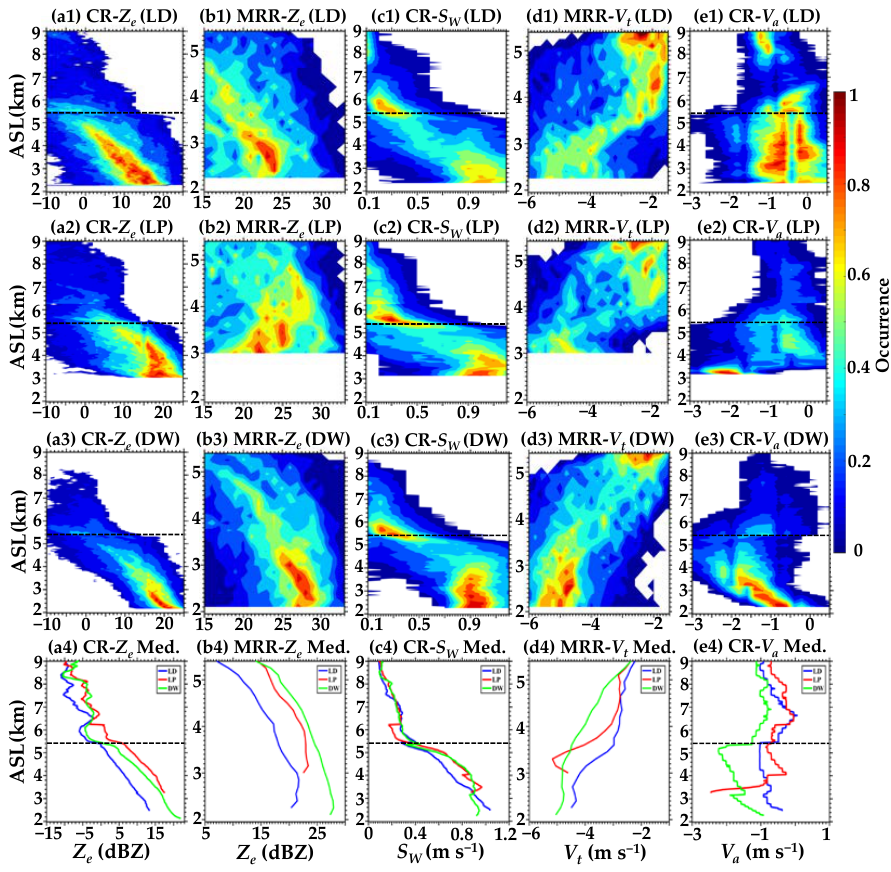
Figure 5. Normalized contoured frequency by altitude diagrams (NCFADs) of equivalent reflectivity factor ( Z e , dBZ), spectrum width ( S W , m s − 1 ), and vertical air velocity ( V a , m s − 1 ) measured by the CR, and Z e (dBZ) and particle falling velocity ( V t , m s − 1 ) measured by the MRR for cumulus mixed cloud and precipitation stage. Subfigures ( a1 – e1 ), ( a2 – e2 ), and ( a3 – e3 ) represent the results at the LD, LP, and DW sites, respectively; ( a4 – e4 ) denote median profiles (Med.) of radar variables; the black dotted line represents the 0 ◦ C isotherm at about 5.4 km,